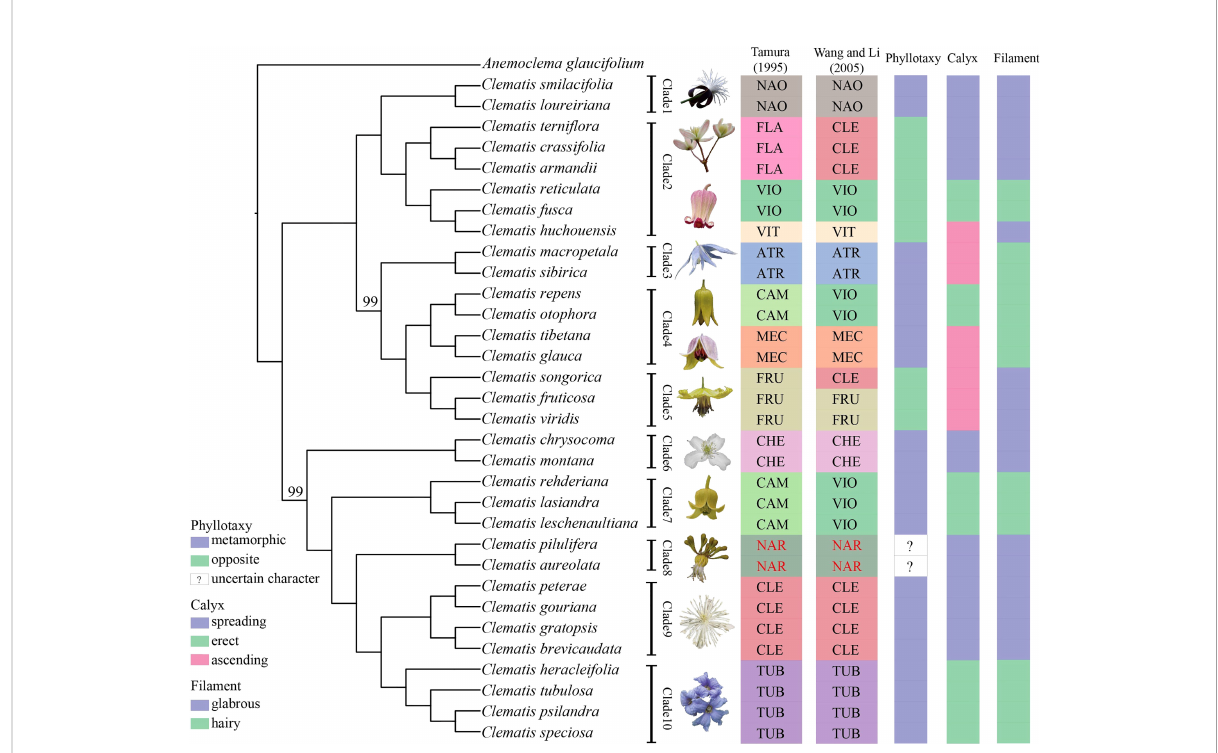
FIGURE 4 A maximum likelihood tree inferred form a nuclear SNPs dataset (Geneious-0.05MS). Two bootstrap values, which are less than 100, are marked above the branch, and all the other branches are fully supported. Section abbreviations follow Figure 3, and three important morphological characters are marked at right side of the